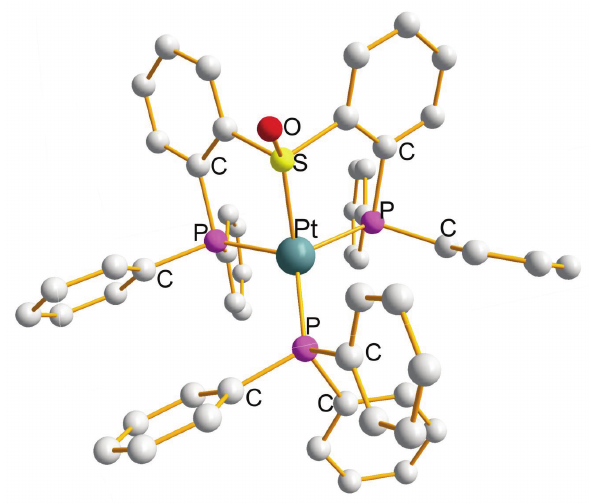
H )PPh }(PPh 6 4 2